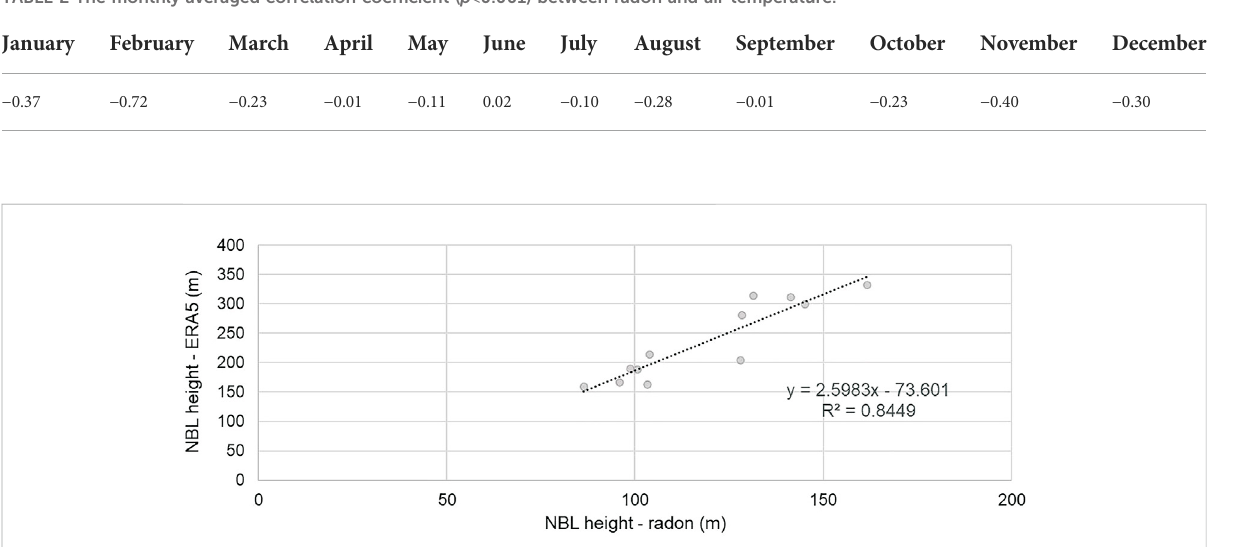
FIGURE 8 Correlation of monthly mean NBL heights obtained from radon-based method and from the ERA5 data.